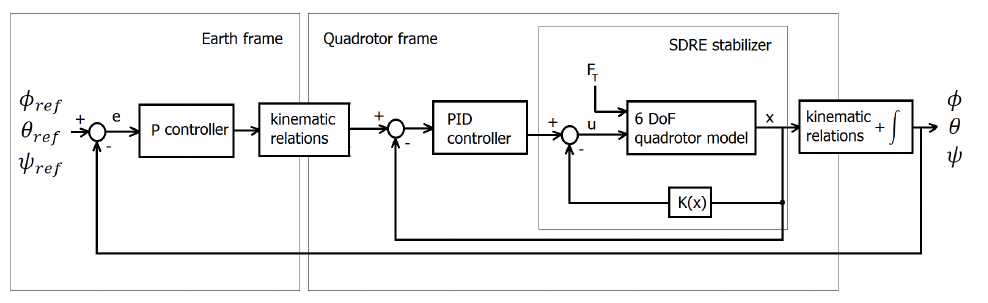
Figure 2. PID-SDRE control schema of the 6 DoF quadcopter